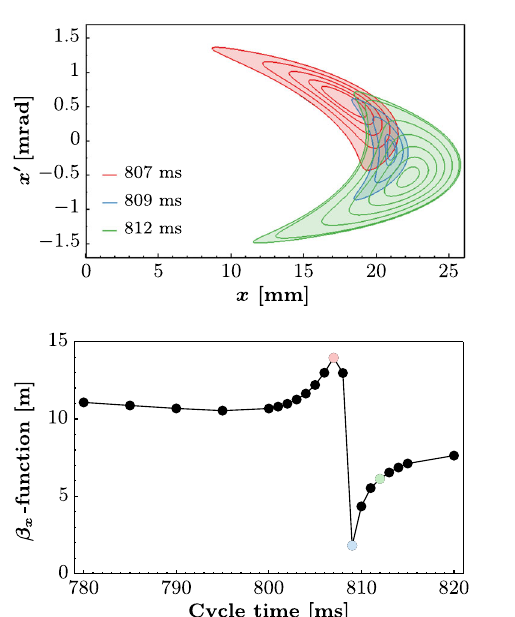
FIG. 17. Time-independent PTC simulation results to demon- strate the behavior of the external island at the entrance to SMH16 during the final rotation. Top: Horizontal phase space. As indicated by the time-dependent simulation results, the island is actually rotated and squeezed before it expands again. The legend indicates the different instances along the cycle. Bottom: Evolution of β x -function. To reduce losses at SMH16, the optimum position of the external beamlet would correspond to the situation at 809 ms. The colored markers correspond to the situations shown in the top figure.